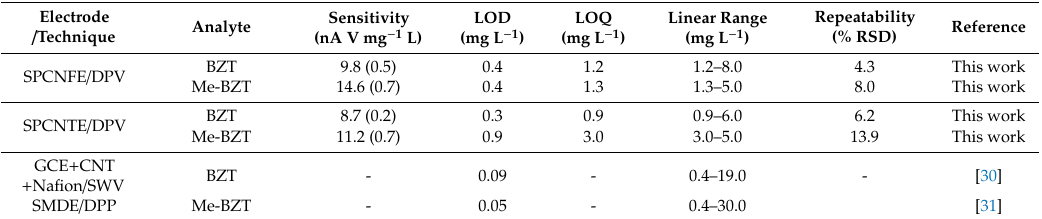
Table 1. Performance of the DPV determination of BZT and Me-BZT by using an SPCNFE and SPCNTE computed from the calibration plots in Figure 5. The standard deviations of sensitivity are denoted in parenthesis. The results are compared with these in refs. [30,31]. LOD: limit of detection; LOQ: limit of quantification; RSD: relative standard